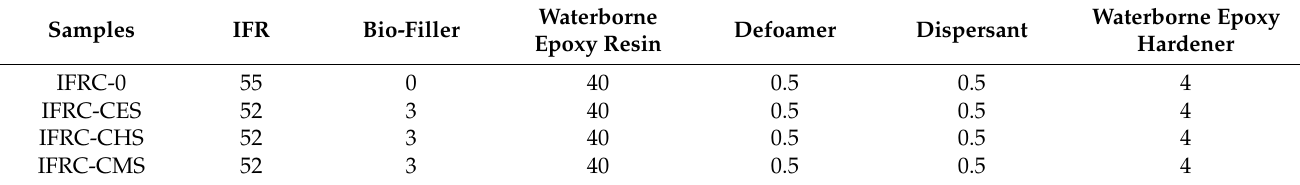
Table 1. Compositions of the intumescent fire-retardant coatings (mass fraction)